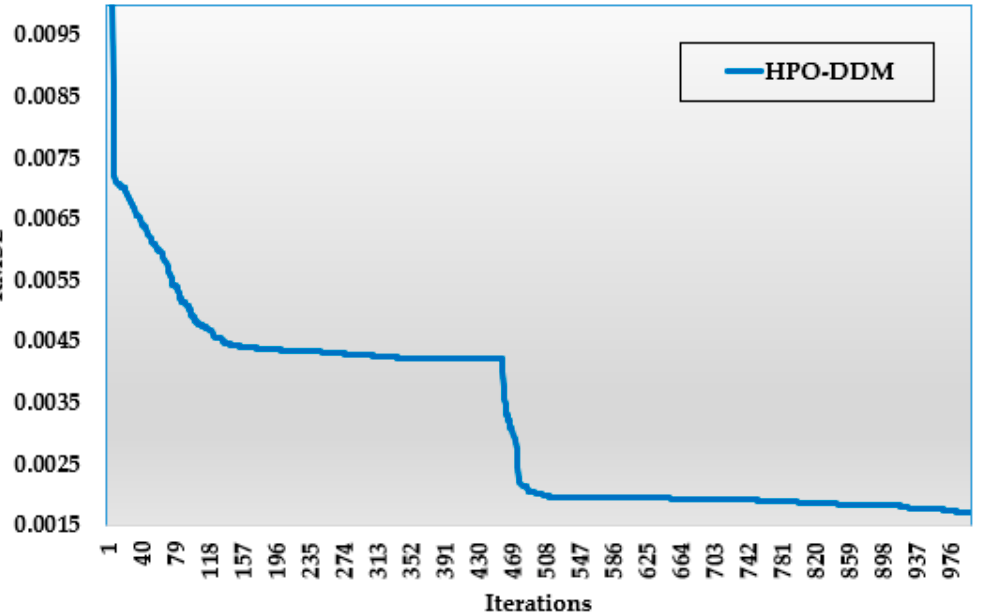
Figure 8. Convergence trend of the proposed HPO technique for the double-diode model of STM6_40/36 PV module.